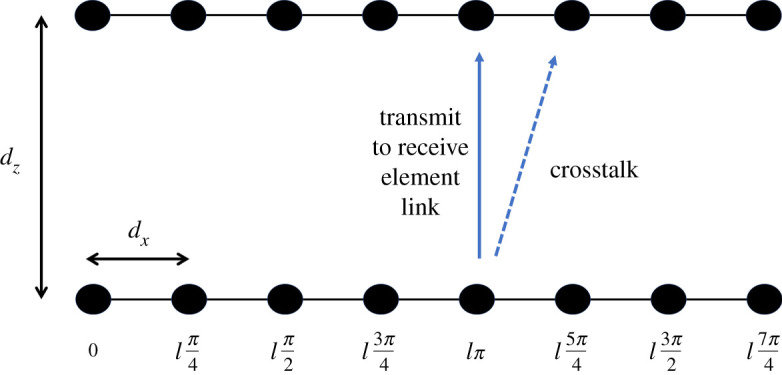
Illustration of the set-up for detection of LAM modes l = −4 to l = +4 for an N = 8 linear array. (Online version in colour.)